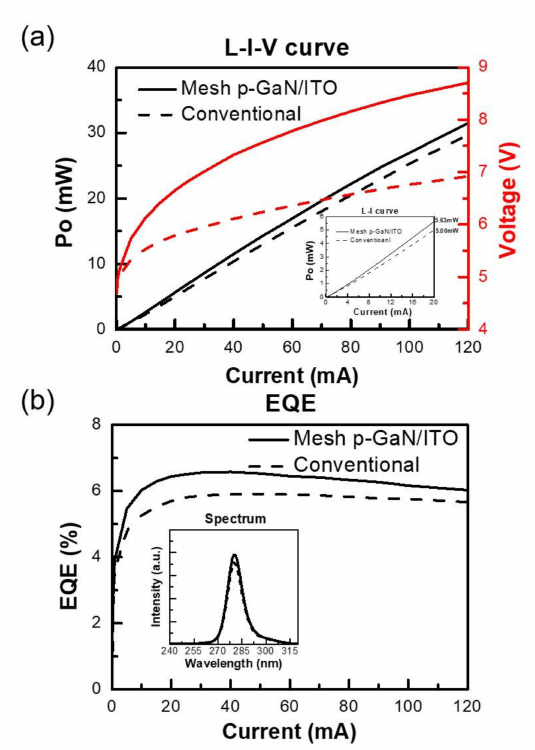
Figure 3. ( a ) The measured L–I characteristics and I–V characteristics of the two kinds of DUV LEDs. The inset shows L-I characteristics from 0 to 20 mA. ( b ) EQE versus current characteristics of the two kinds of DUV LED. The inset shows the emission spectra of the two kinds of DUV LEDs. The solid line and dashed lines are data curves for the mesh p-GaN / ITO DUV LED and the conventional DUV